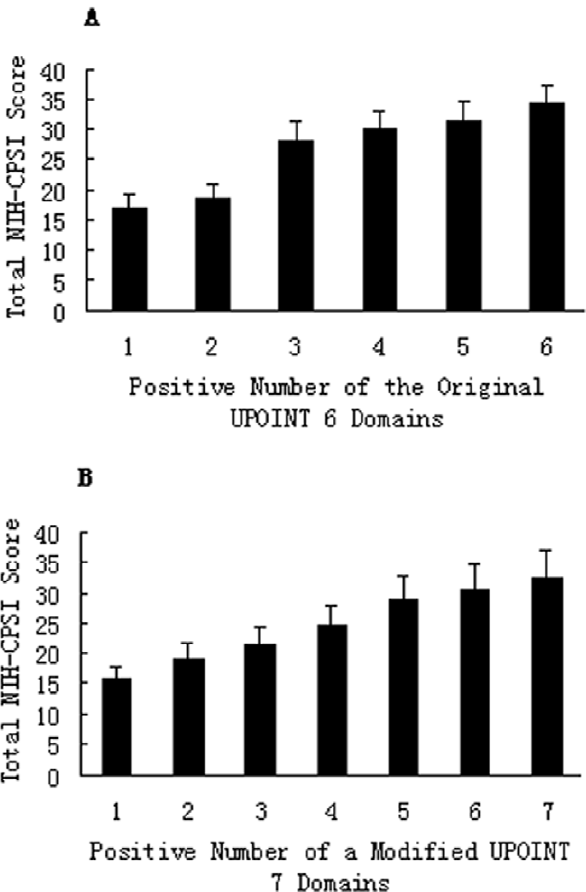
Figure 1. Correlation between NIH-CPSI symptom scores and UPOINT(S) positive number. Mean total NIH-CPSI symptom scores were compared with the positive number of the original UPOINT 6- domains (A) and a modified UPOINTS 7-domains created by adding an ED domain (B), respectively. Significant difference was seen in the NIH- CPSI total score between groups in A and between groups in B (all P , 0.001), respectively. Correlation coefficient r improved from 0.706 (A) to 0.844